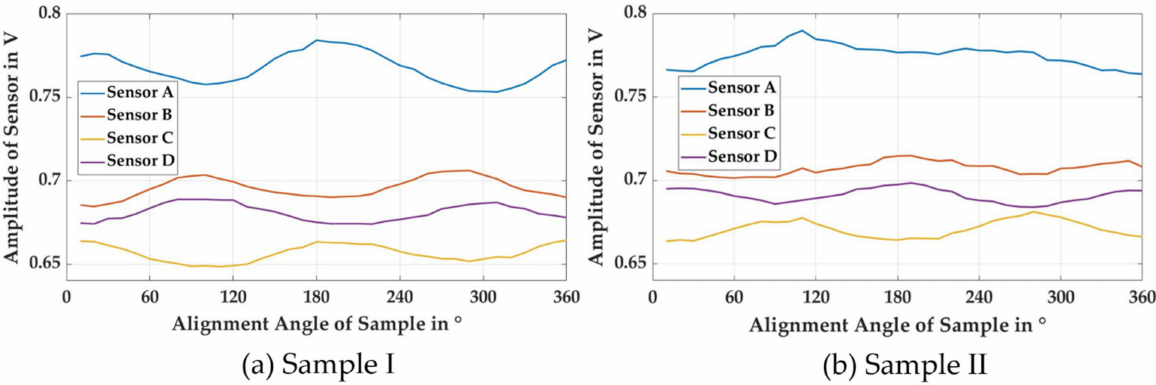
Figure 5. Rotational measurement of sample I and sample II in intervals of 10 ◦ to observe the effect of anisotropy for the cases of ( a ) strong anisotropy and ( b ) weak anisotropy.